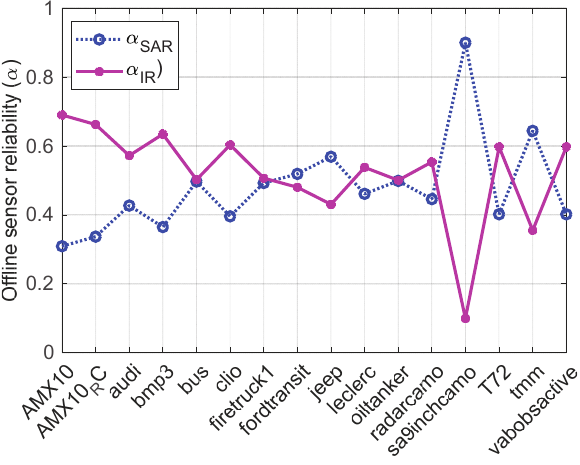
Figure 7. Estimated SAR/IR sensor offline